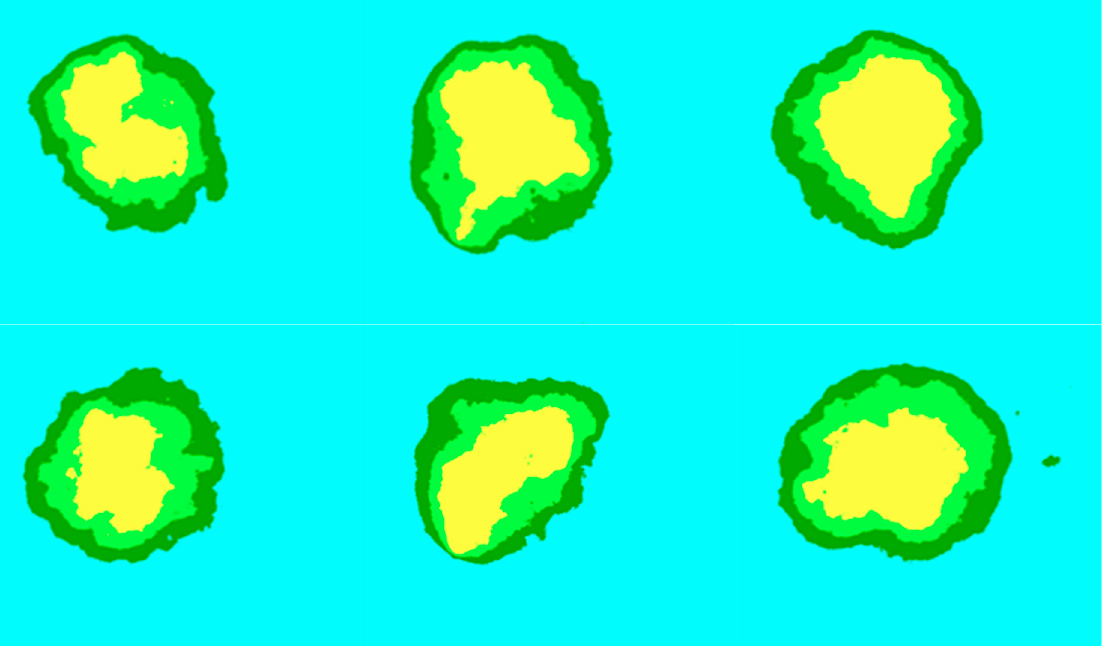
Figure 10. Conditional values of inhalation doses in the absence of a directed wind and the presence of random turbulent movements of the environment.